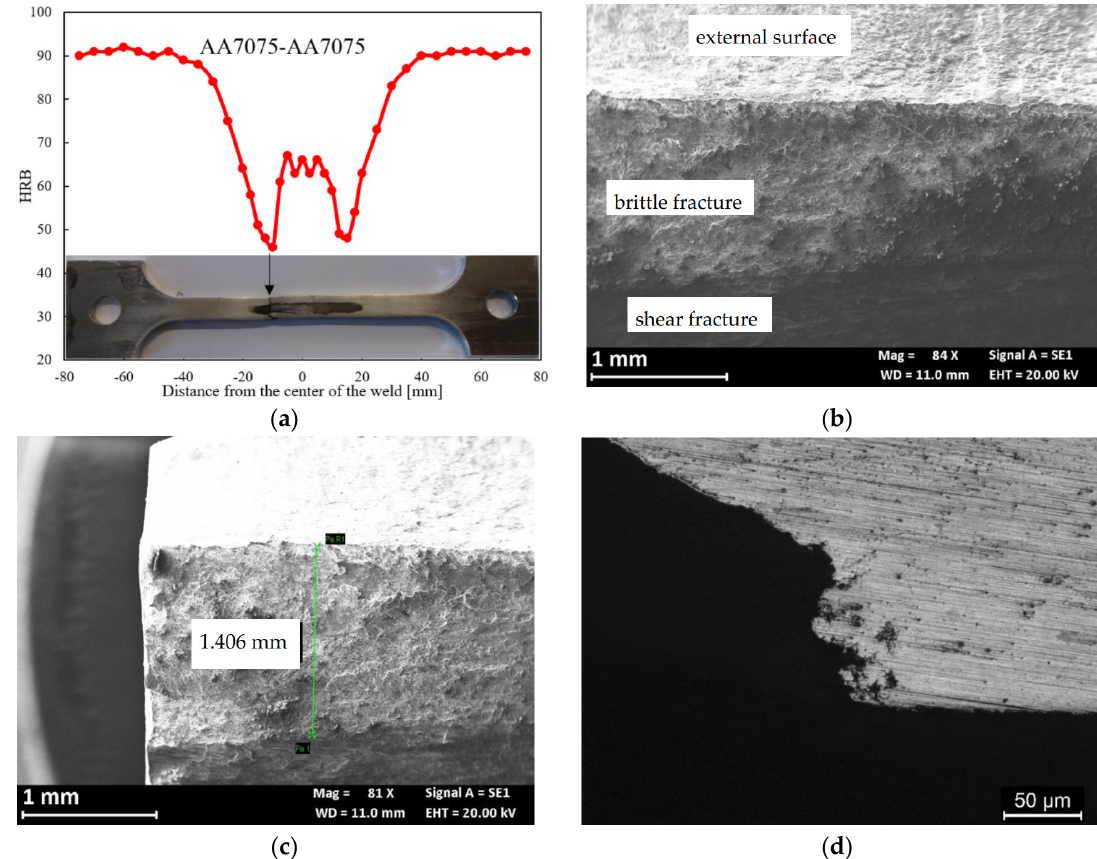
Figure 18. ( a ) Hardness profile along the FSW butt joint; ( b ) SEM image of the fracture surface, a flat zone of about 1 mm of growth (close ‐ up in ( c ) is highlighted in ( d )) metallographic section of the fracture surface in which is visible the flat zone and the small ramifications.